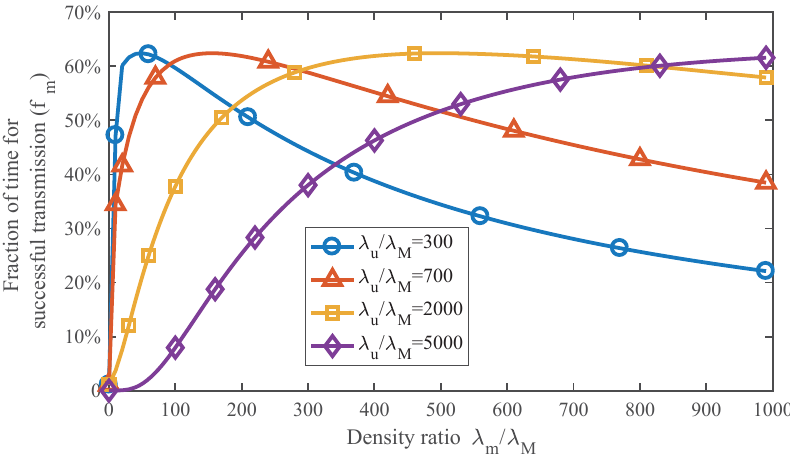
Figure 6. The effect of SmBS density on the channel efficiency under different user densities. P m / P M =